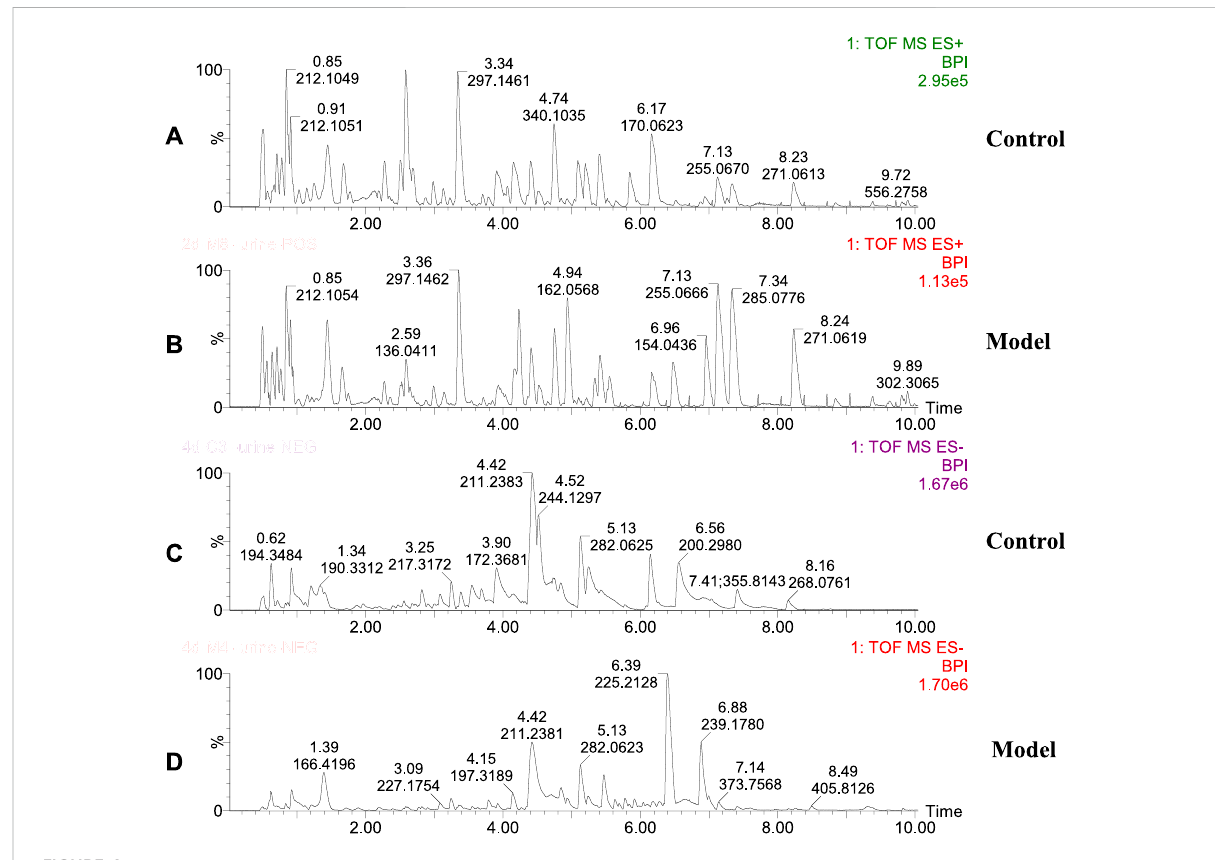
FIGURE 4 Representative base peak intensity (BPI) of rat urine in groups C and M. (A) Urine of group C rats, positive ion mode; (B) Urine of group M rats, positive ion mode; (C) Urine of group C rats, negative ion mode; (D) Urine of group M rats, negative ion